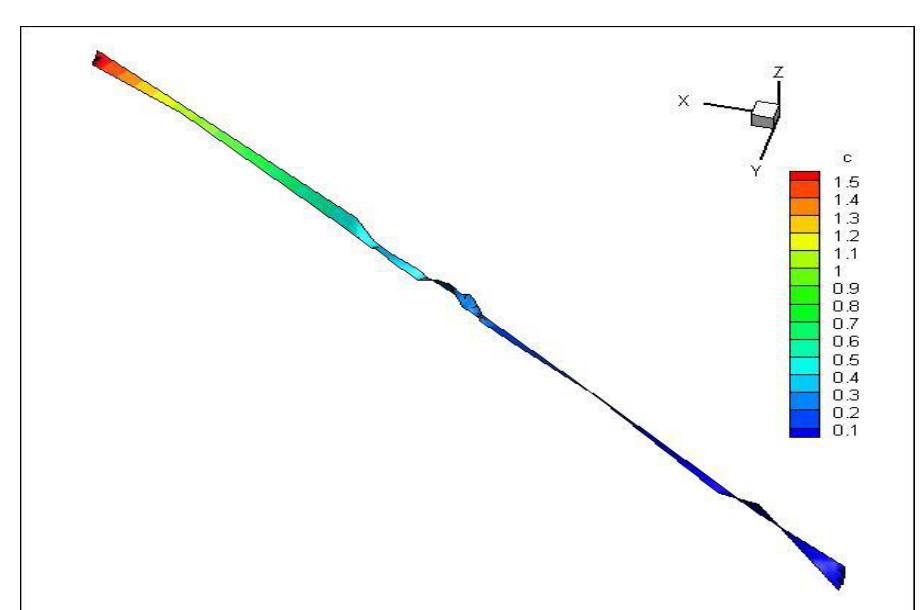
Fig. 5 simulated pollutant concentration in the Ajichai river